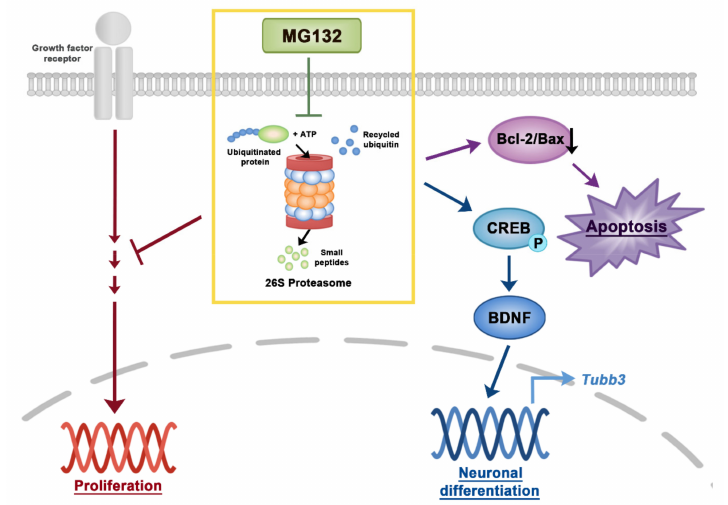
Figure 7. A scheme of signaling pathways in NSCs induced by MG132. Inhibition of proteasome by MG132 induced apoptosis by decreasing the Bcl-2 / Bax ratio in NSCs. In addition, MG132 increases neuronal di ff erentiation or survival in NSCs by activating CREB and BDNF. Proteasome inhibition by MG132 inhibited NSC proliferation in the presence of growth